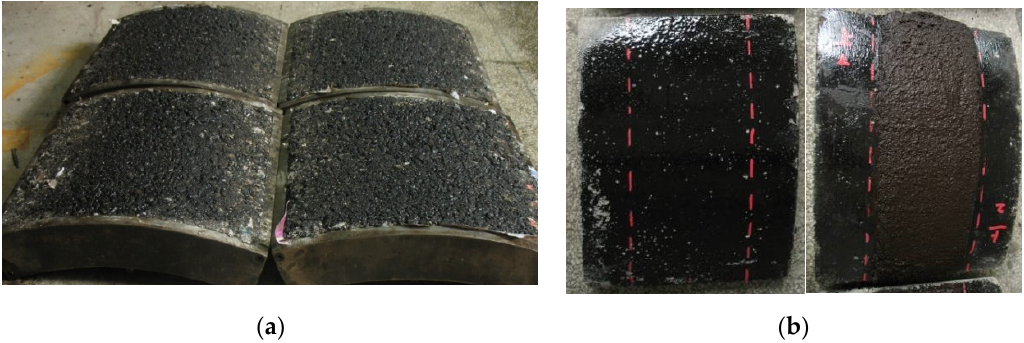
Figure 6. Arc-shaped specimens used in the test: ( a ) arc-shaped specimens of asphalt mixture and ( b )